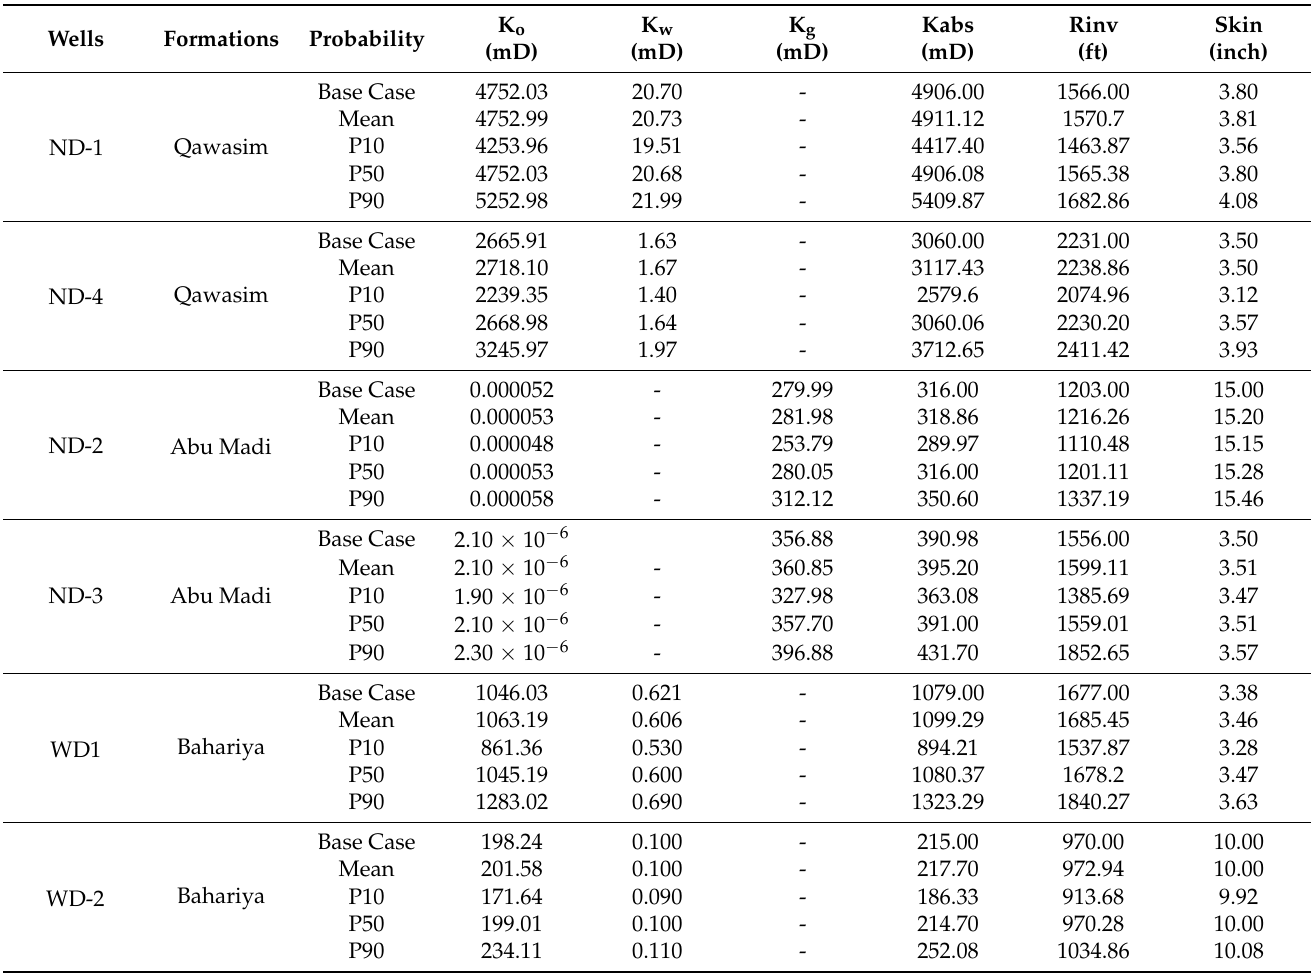
Table 5. The results of well test uncertainty analysis (mean value and output percentiles: 10, 50, and 90%) for all pay zones of the studied wells.